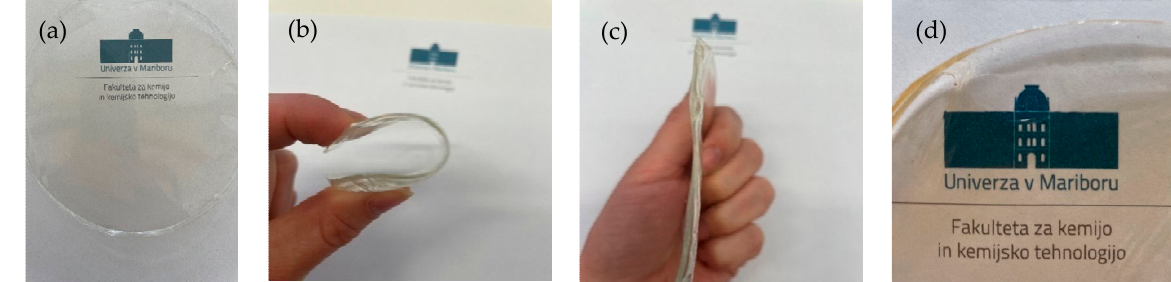
Figure 1. (a) EC film prepared in EtOH. ( b ) Bendable properties of the film. ( c ) Shape recovery after the forced removal. ( d ) TiO 2 -incorporated EC film prepared in EtOH. Table 1. Properties of the EC films.